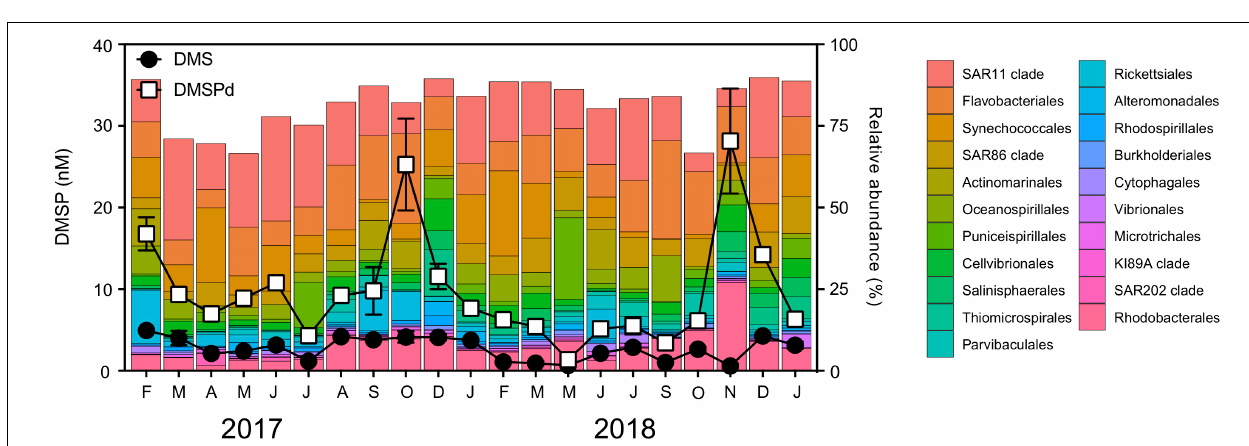
FIGURE 4 | Concentrations of DMS and DMSP lyase activity (DLA) of (A) phytoplankton (DLAp) and (B) bacteria (DLAb) at Port Hacking NRS between February 2017 and January 2019. Data are means ± standard error ( n = 3).